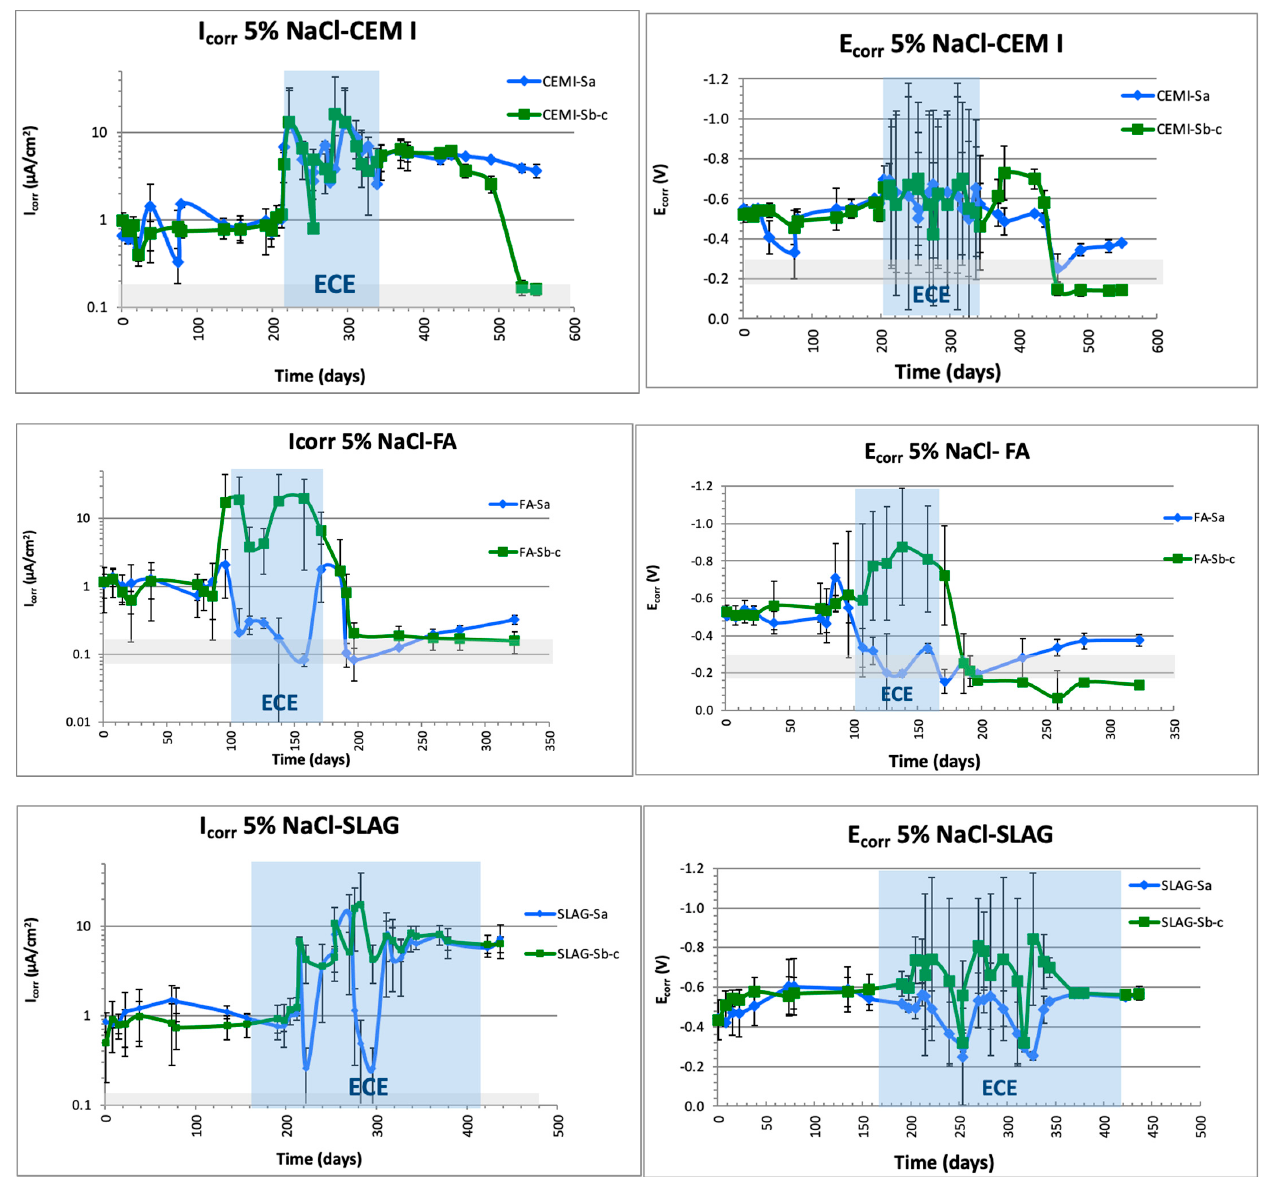
Figure 10. Corrosion potential and corrosion rate (E corr and I corr ) monitoring.